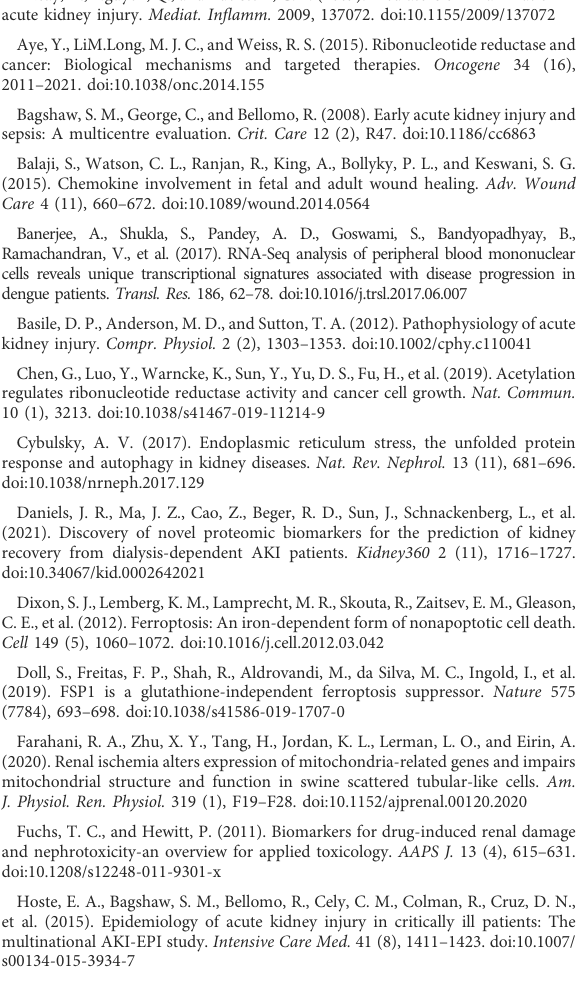
SUPPLEMENTARY FIGURE S1 Immune in fi ltration analysis. (A) In fi ltration fraction overview of 22 immune cells and a comparison of in fi ltration scores in two groups. The horizontal axis is immune cells and the vertical axis is in fi ltration fraction. (B) Immune cell in fi ltration cluster. (C) The proportion of the in fi ltrating immune cells. (D) Correlation analysis of ferroptosis genes and immune cells in